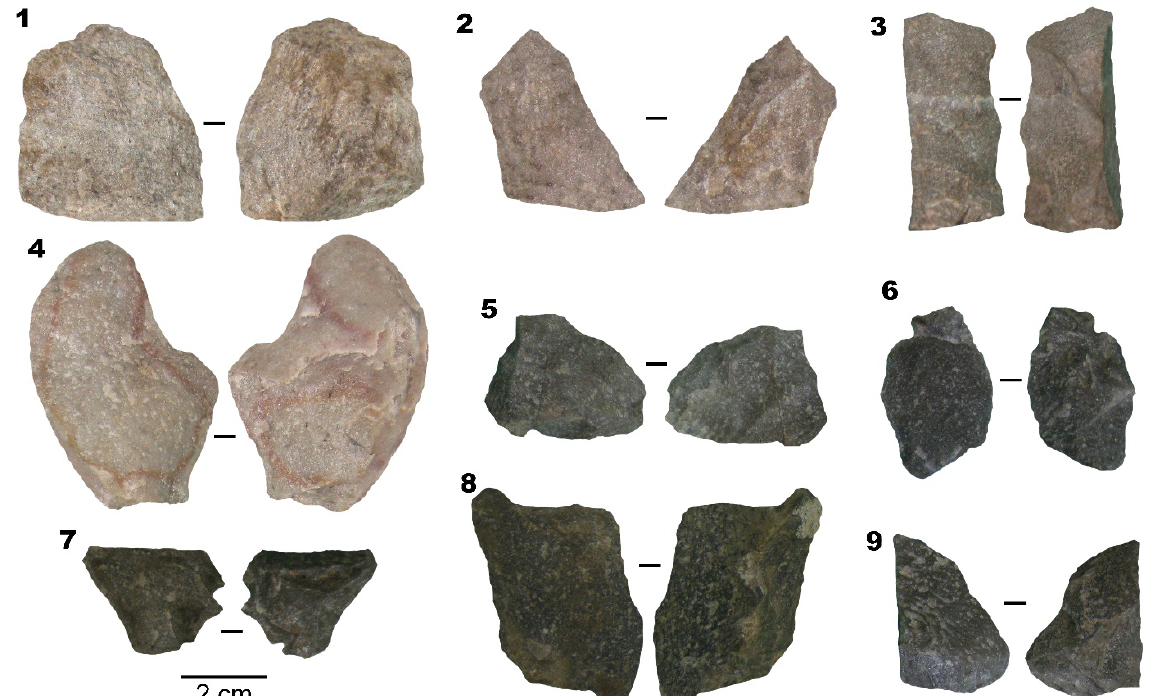
Figure 2. Quartzites selected to make thin section and X-ray fluorescence (marked with an asterisk) from the Level XXII-R. 1) ES-263*: CA type; 2) ES-283: OO type; 3) ES-255*: OO type; 4) ES-245*: OO type; 5)